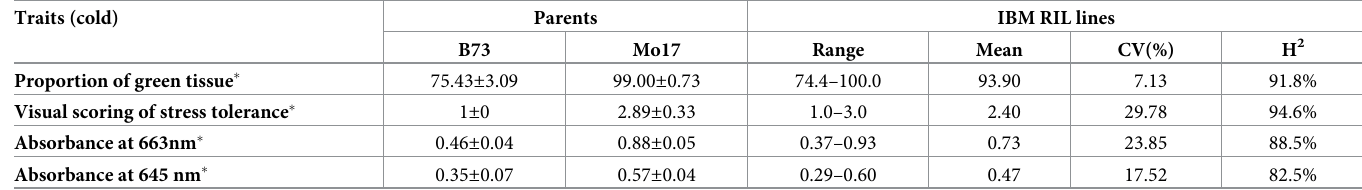
The traits designated with stars showed statistically significant differences between Mo17 and B73 parents (Student